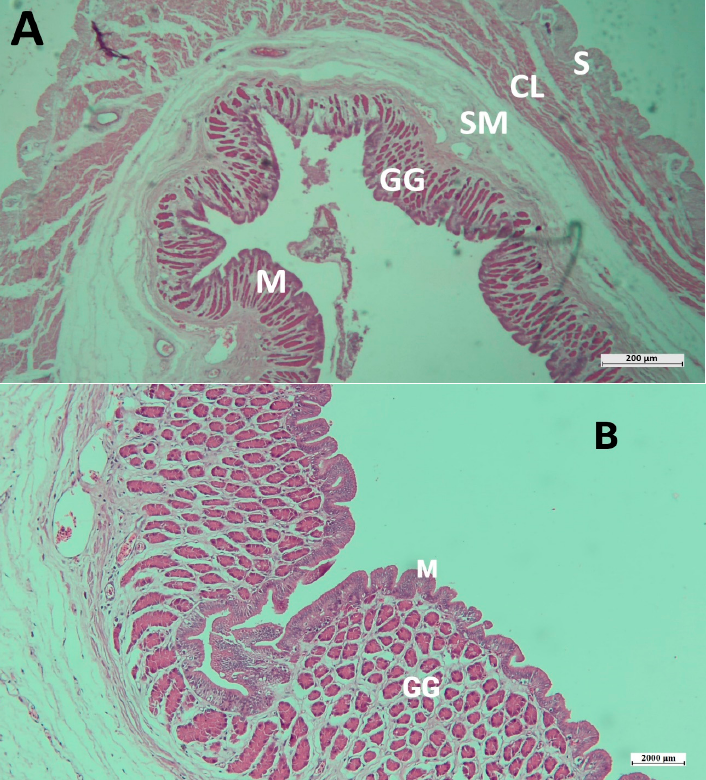
Figure 6. Transverse photomicrographs of a section of the stomach in N. nandus ( A , B ) where, GG: gastric gland, SM: submucosa, CL: inner circular muscle layer, S: serosa, M: mucosa.